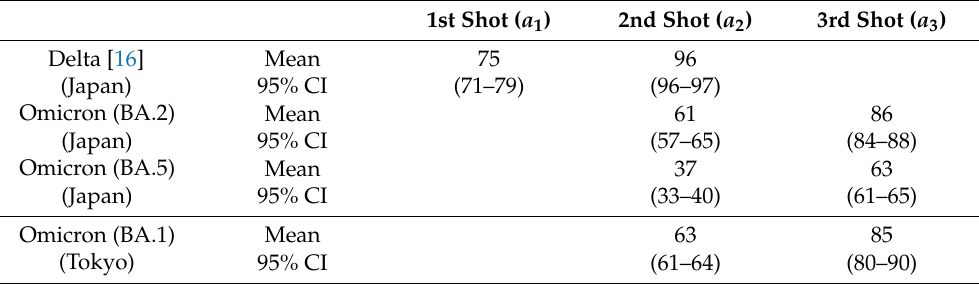
Table 1. Parameters for the individual VE of second and third shots used in Equation (1) for Omicron variants. For comparison, the parameters for parameters in Tokyo derived in our previous study [16] are also